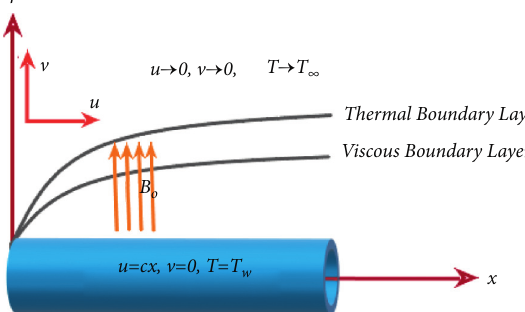
Figure 1: Schematic for stretching cylinder submerged in a stationary